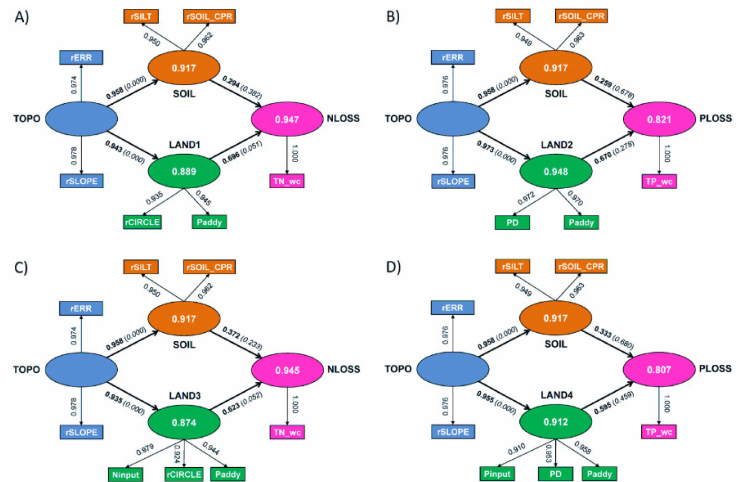
Figure 4. Relationships of the topographic factor (TOPO), the landscape factor (LAND1-4) and the soil factor (SOIL) with the catchment N (TN_wc, A , C ) and P (TP_wc, B , D ) loadings, deter- mined by path analysis using structural equation modeling (SEM) solved by the partial least square (PLS) method—PLS-SEM. The TOPO, SOIL, LAND, NLOSS and PLOSS factors are the five pro- posed latent variables for the PLS-SEM analysis. The conceptual theory of the PLS-SEM analysis assumes that the topography (TOPO) impacts the catchment N and P loadings through two path- ways: SOIL and LAND. As a result, the specific indirect effects (TOPO → SOIL → N/PLOSS and TOPO → LAND1/2/3/4 → N/PLOSS) were estimated to examine the impacting pathways. Chi-square is-2 × log (the model likelihood value); nfi is the nonfuzzy index; srmr is the standardized root mean residual; R pls2 is the coefficient of determination for NLOSS and PLOSS predicted by the TOPO, SOIL and LAND